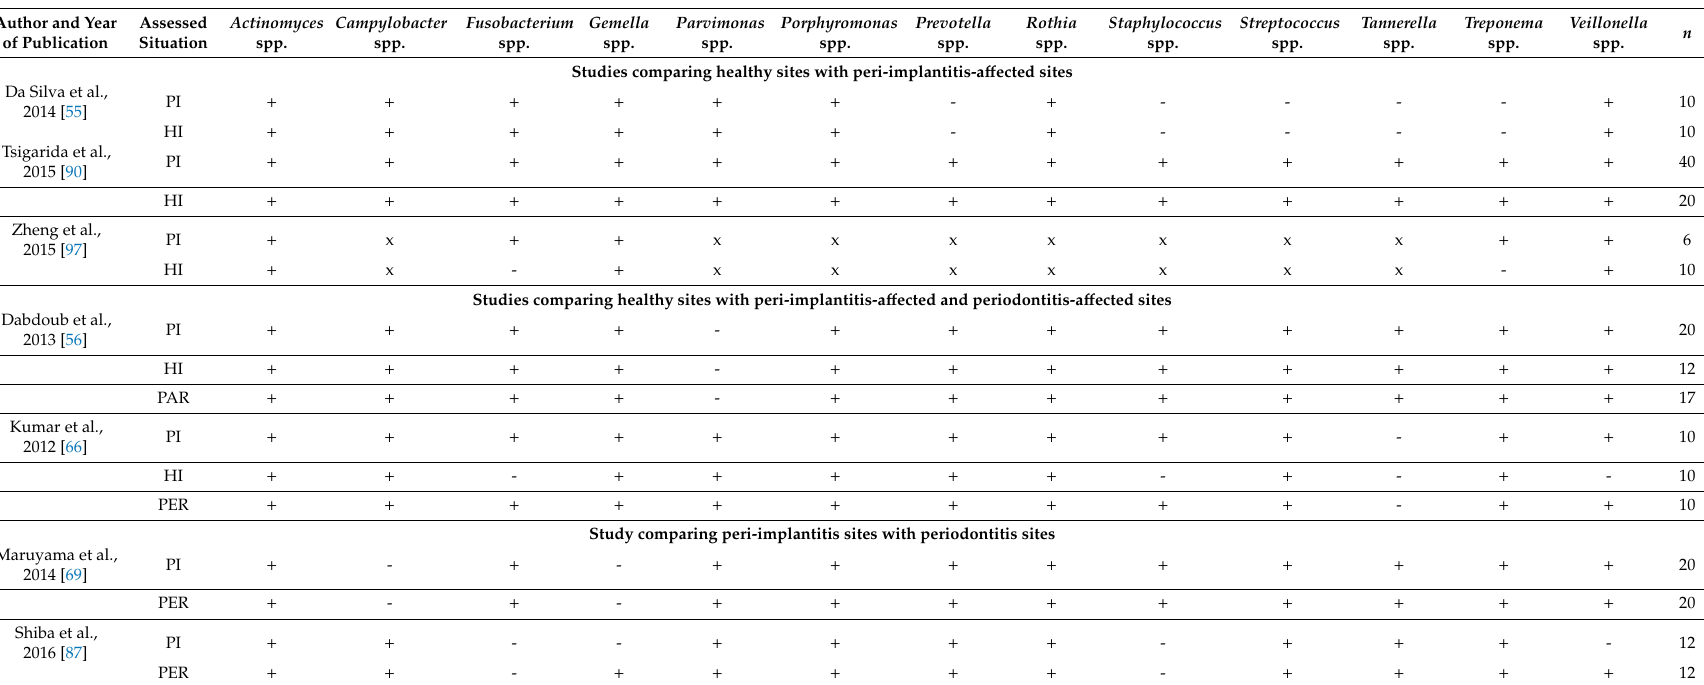
Table 5. Studies assessing di ff erent species using